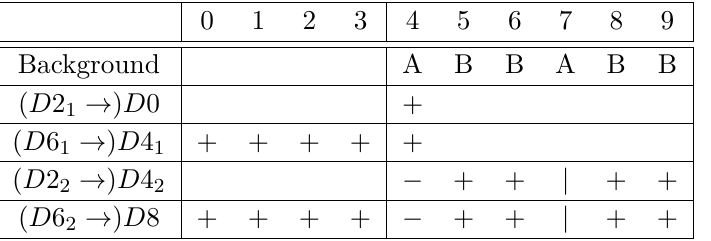
Table 1 . Brane configuration after the T-duality. A and B denote angles and B-field. For instance, D4 and D8 branes extend over an oblique line in 47 2